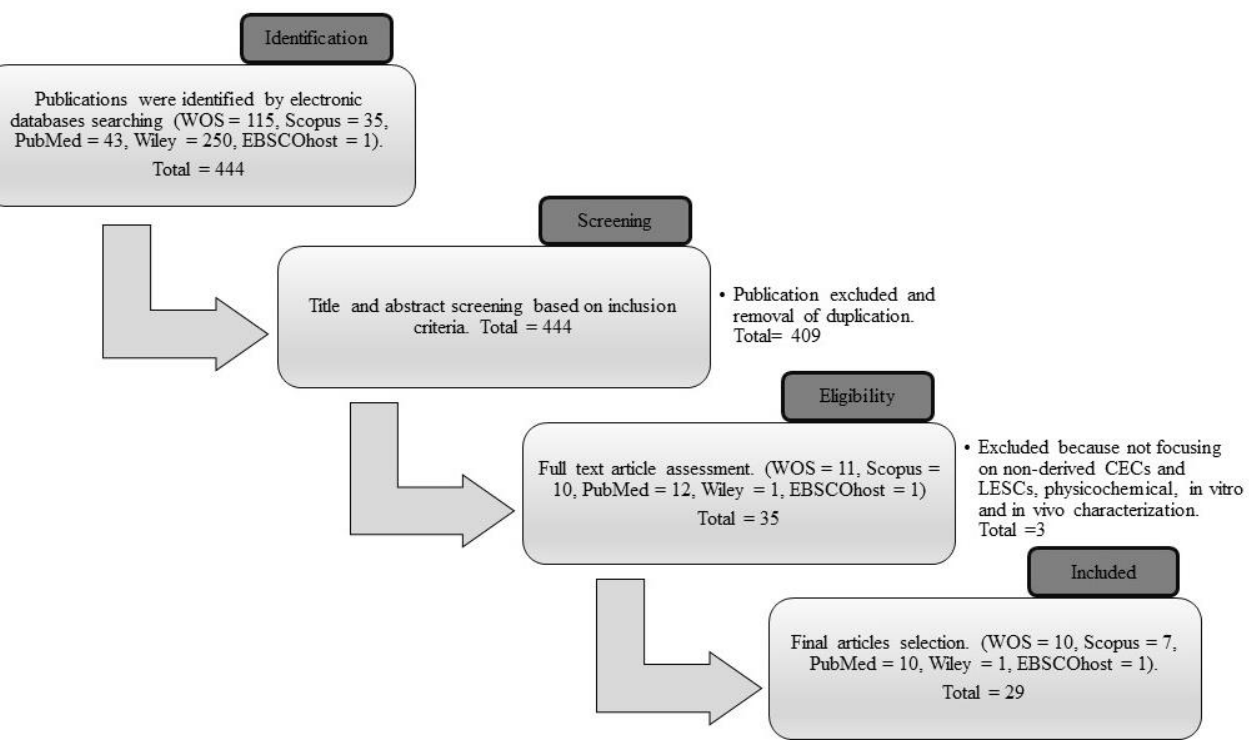
Figure 3. The process flow of the selection of the final articles from Web of Science (WOS), Scopus, PubMed, Wiley, and EBSCOhost databases.